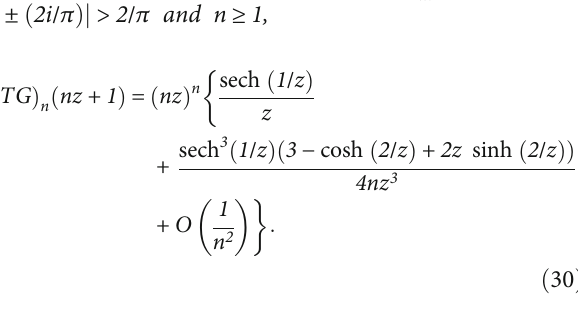
Figure 2 below depicts the graphs of ð TG Þ n ð nz + 1 Þ (in solid lines) generated using relation (9) and the graphs of the approximate values of ð TG Þ n ð nz + 1 Þ (in dashed lines) generated using the expansion at the right-hand side of (30).